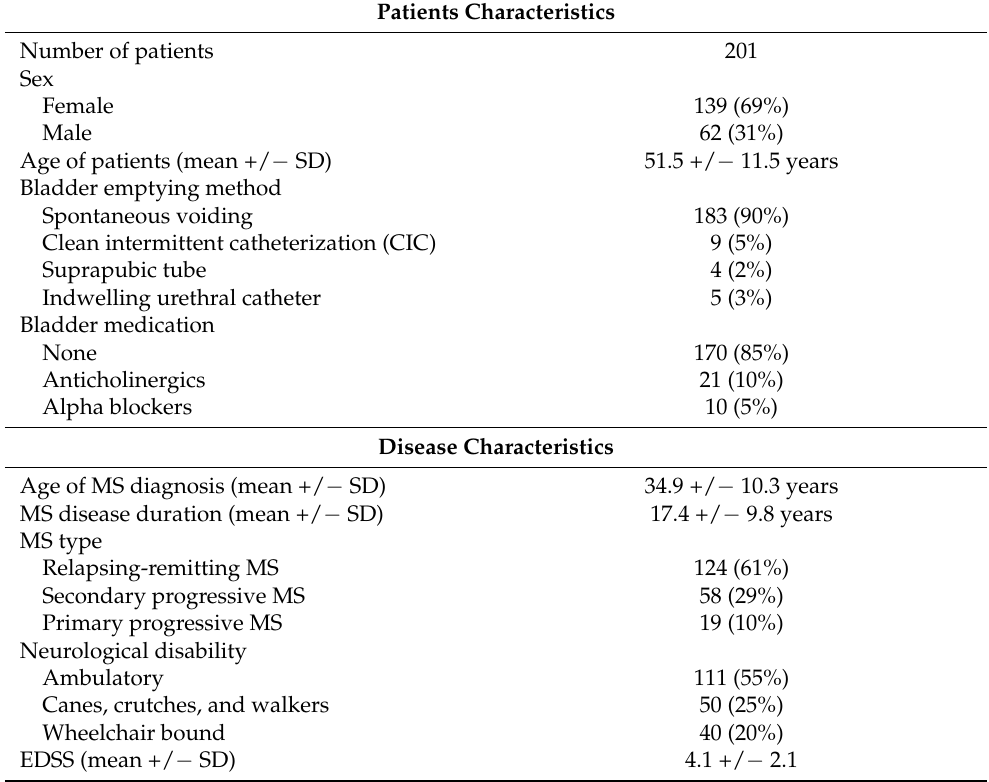
Table 1. Patients and disease